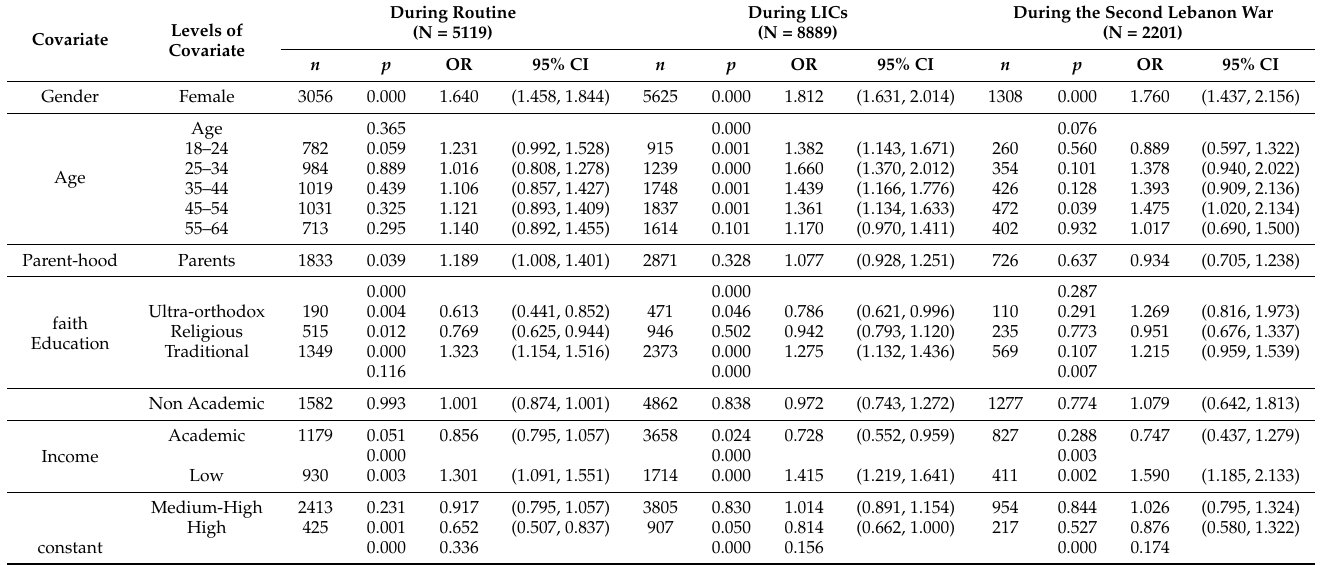
Table 5. Binary logistic model predicting “fear of getting physically injured” during LIC and during routine, stratified